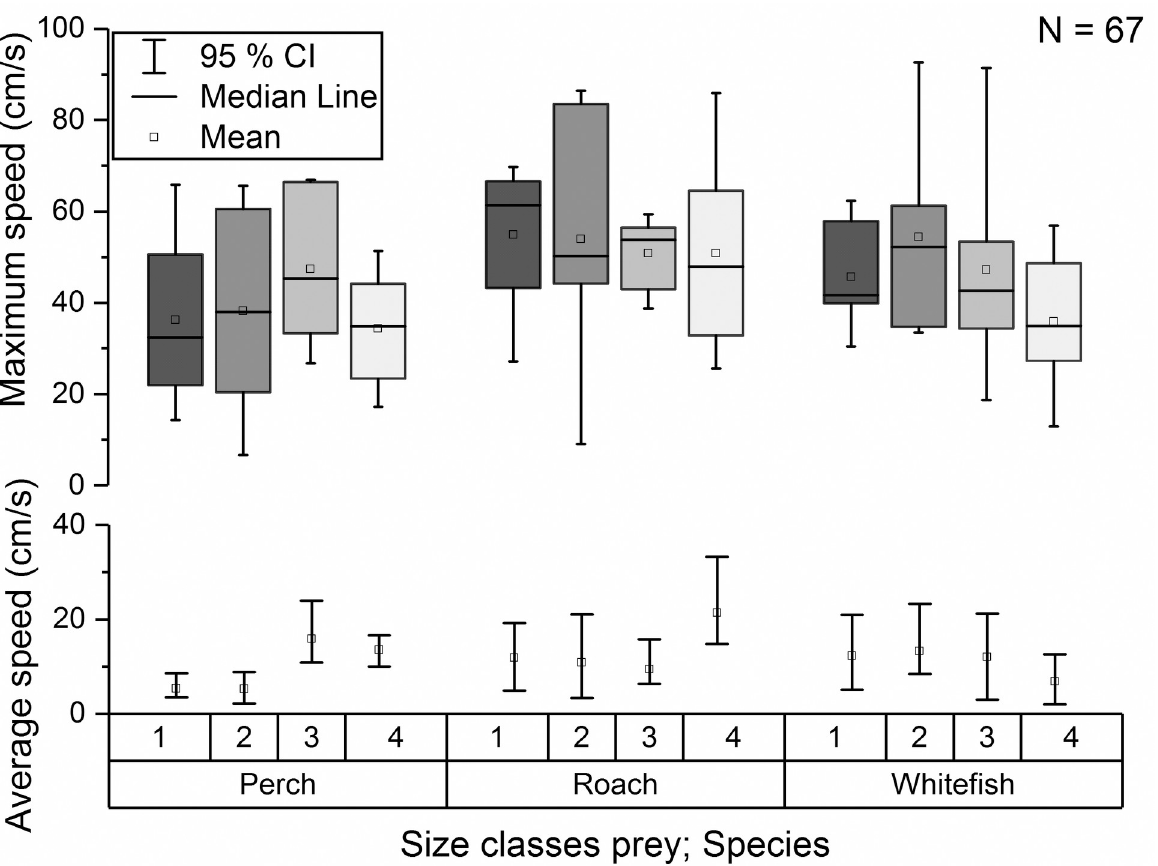
Fig 6. Maximum and average speed of prey. Maximum and average speed of prey (cm/s) in failed hunts divided by species and size class.